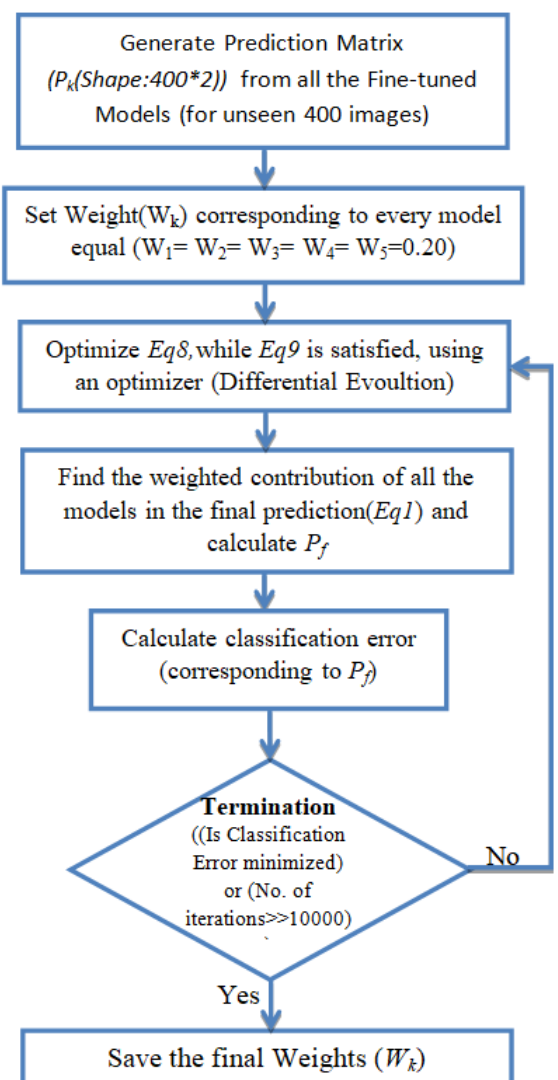
Figure 5. Procedure followed while calculating the optimal weight corresponding to every model.